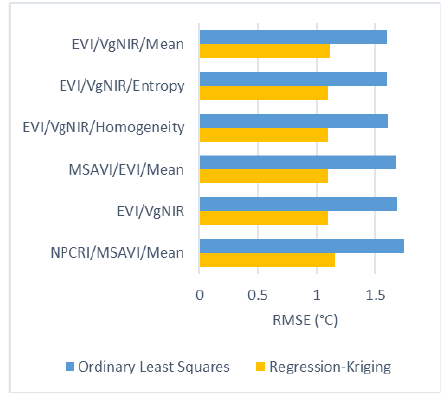
Figure 4. Comparison of RMSE between OLS and RK